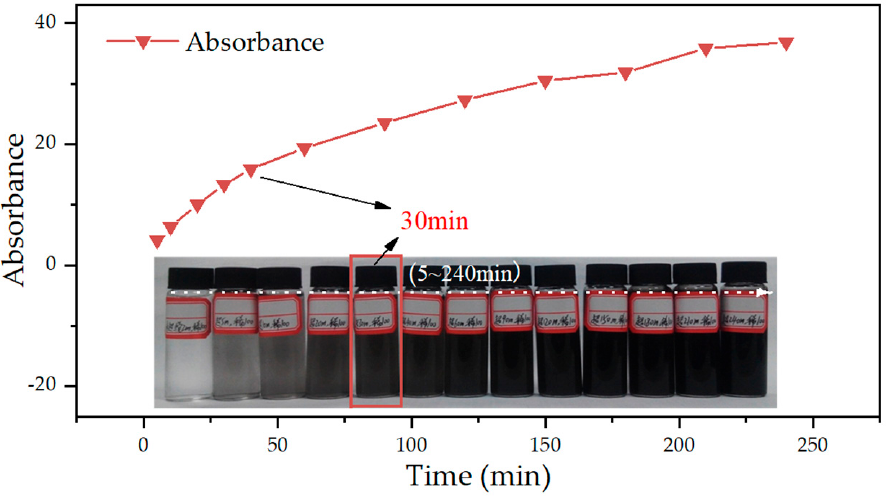
Figure 5. Absorbance of GNPs suspension in different ultrasonication time (inset: sample image).